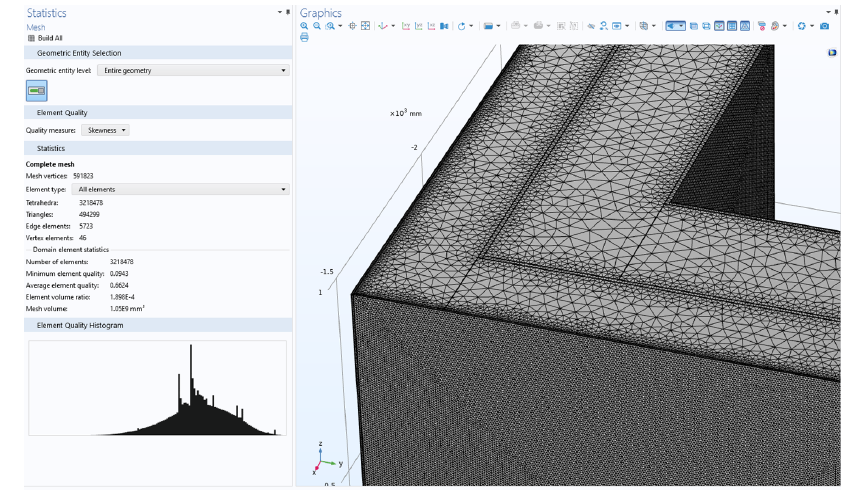
Figure 5. Meshed element originated from BIM.